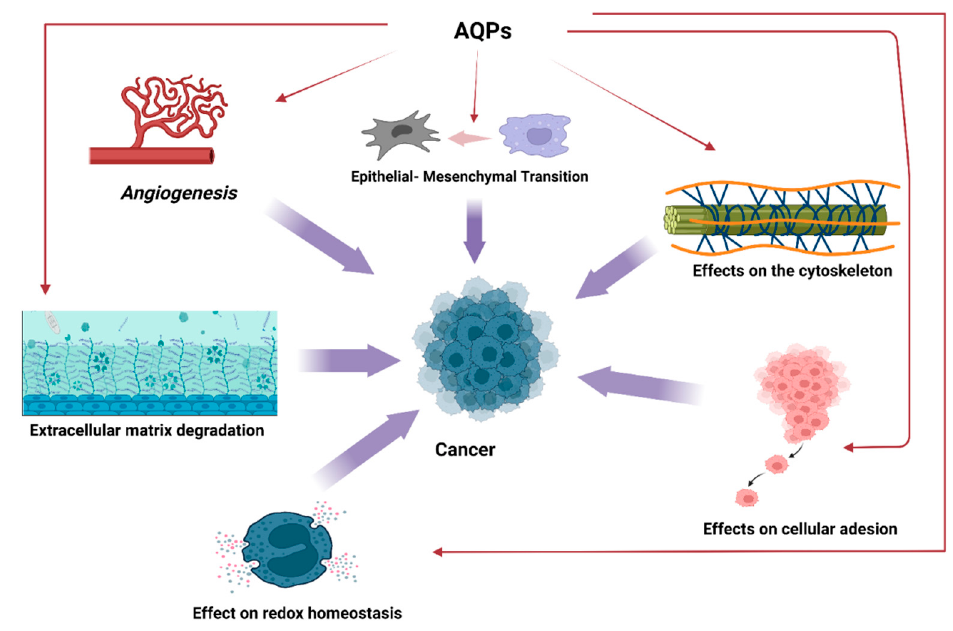
Figure 3. Effects of AQPs in onset and progression of cancer